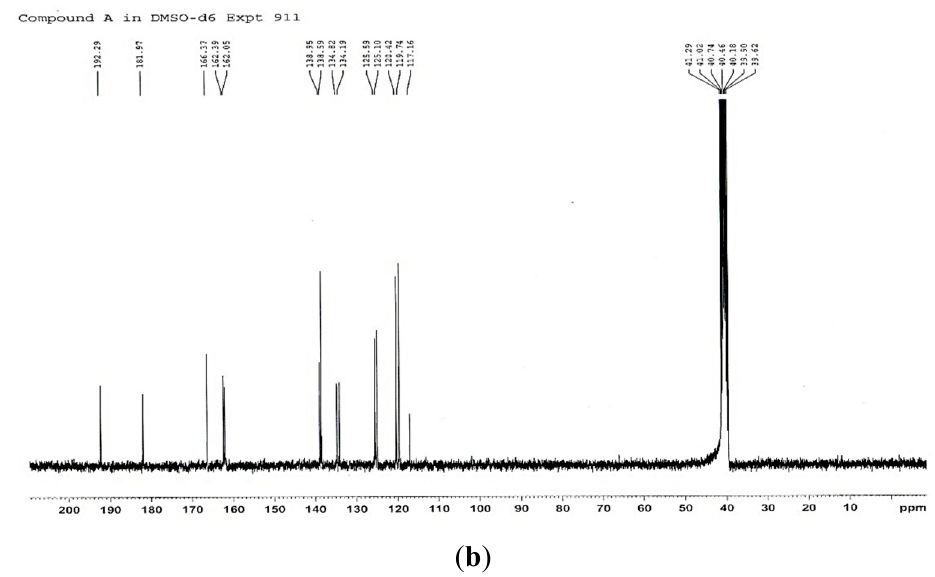
Figure 10. ( a ) 1 H- and ( b ) 13 C-NMR spectra of the isolated rhein.